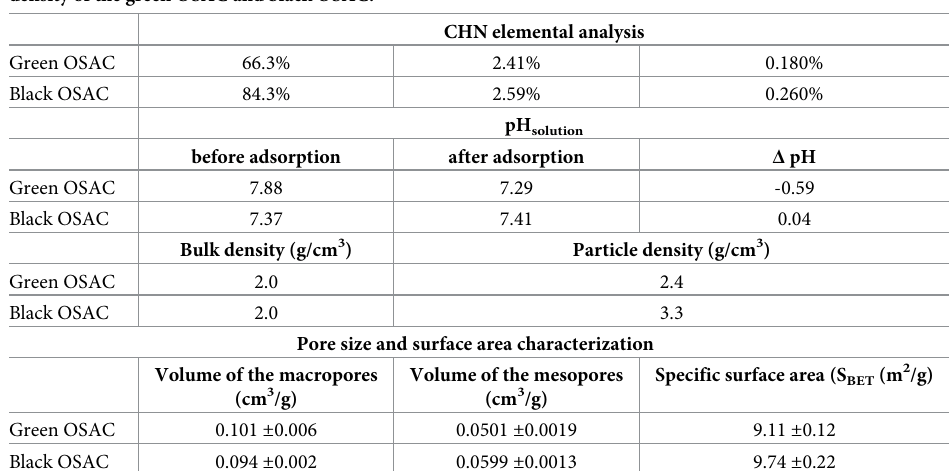
Table 1. CHN elemental analysis, pH solution , pore size and surface area characterization, bulk density and particle density of the green OSAC and black